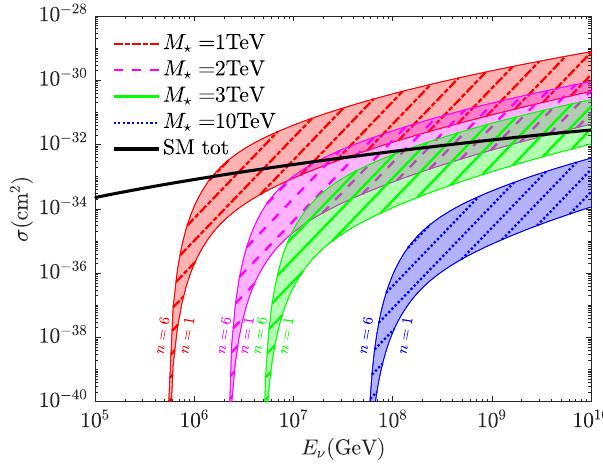
Figure 1 . The black hole production cross section from neutrino-nucleon interactions as a function of the incoming neutrino energy. The hatched colored bands correspond to M ? = 1 TeV (dash-dotted red), 2 TeV (dashed magenta), 3 TeV (solid green) and 10 TeV (dotted blue) respectively. For each band, the lower limit represents n = 1 extra dimensions and the upper bound has n = 6. The total Standard Model (SM) neutral current and charged current cross section is shown by the black